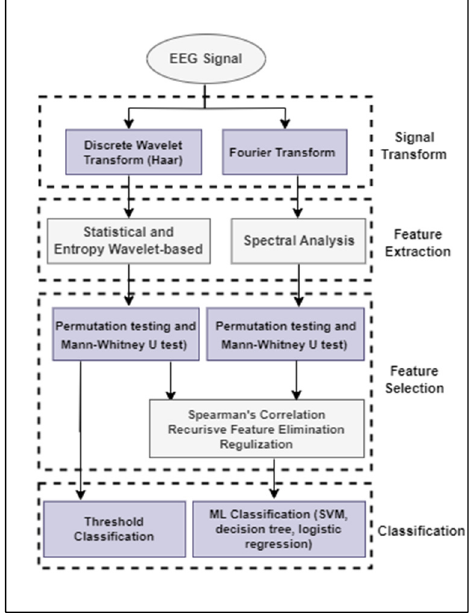
Figure 3. General adopted methodology for the EEG-based scheme design.